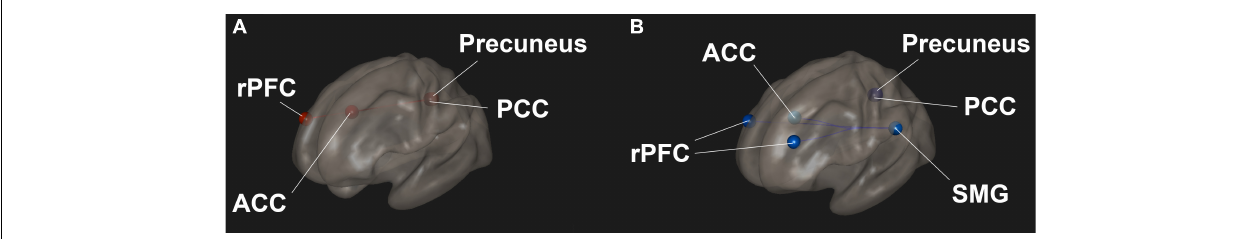
FIGURE 2 | Changes in functional connectivity was observed in meditators and comparisons were made before and after the Samyama program. (A) Functional connectivity was increased between the anterior cingulate cortex (ACC) of the salience network and posterior cingulate cortex (PCC) and precuneus of the default mode network (DMN) in the resting state condition. The PCC also had increased connectivity to the rostral prefrontal cortex (rPFC). (B) Functional connectivity was decreased within the salience network between the supramarginal gyrus (SMG) and ACC and rPFC in the focused breathing condition. Red indicates increased connectivity and blue indicates decreased